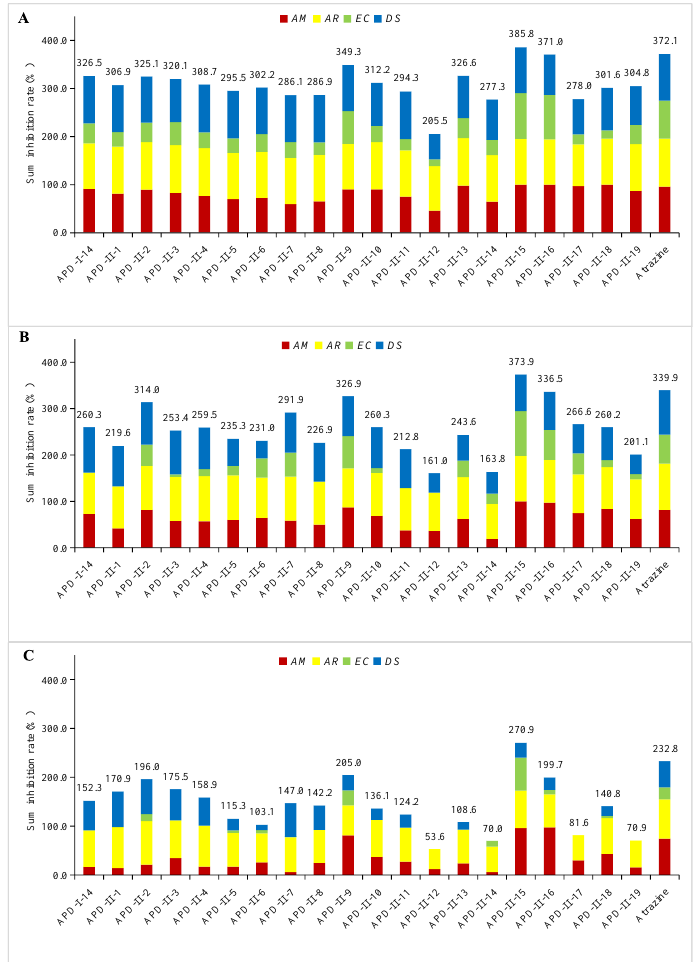
Figure 5. Effects (% inhibition) of compounds APD-I-14 , APD-II-1 to APD-II-19 on loss of plant weight at a different dosage under pre-emergence conditions after treatment at 14 days; ( A ) at a dosage of 750 g ha − 1 ; ( B ) at a dosage of 375 g ha − 1 ; ( C ) at a dosage of 187.5 g ha − 1 . Abutilon theophrasti Medicus (AM), Amaranthus retroflexus L. (AR), Echinochloa crus-galli (EC) Digitaria sanguinalis (L.) Scop. (DS).